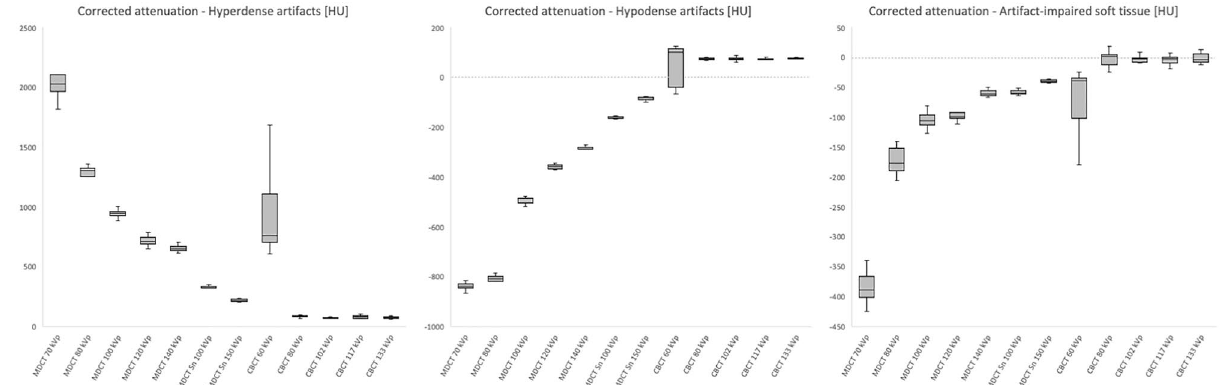
Figure 4. Boxplots with signal attenuation in artifacts and artifact-impaired soft tissue. Note—Boxplots (median and 50% of cases within the boxes) illustrate the corrected signal attenuation in Hounsfield units (HU) for hyperdense artifacts, hypodense artifacts and artifact-impaired soft tissue in cone-beam computed tomography (CBCT) and multidetector computed tomography (MDCT) with different levels of tube voltage (kVp = kilovoltage